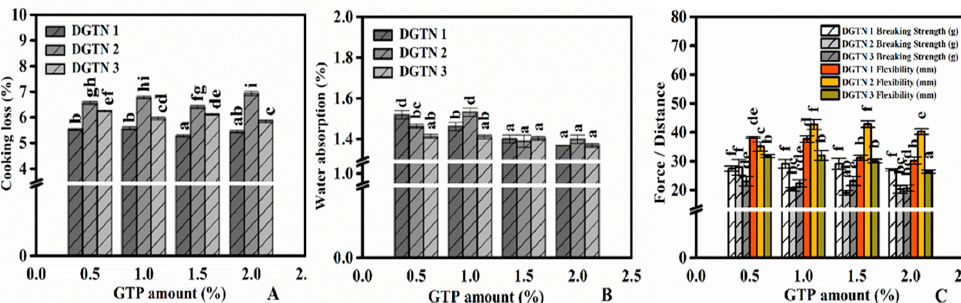
Figure 2. Effects of GTP with different particle sizes or concentrations on the cooking loss ( A ), water absorption ( B ) and breaking strength and elasticity ( C ) of dried green tea noodles (DGTN). Different lowercase letters show significant differences.